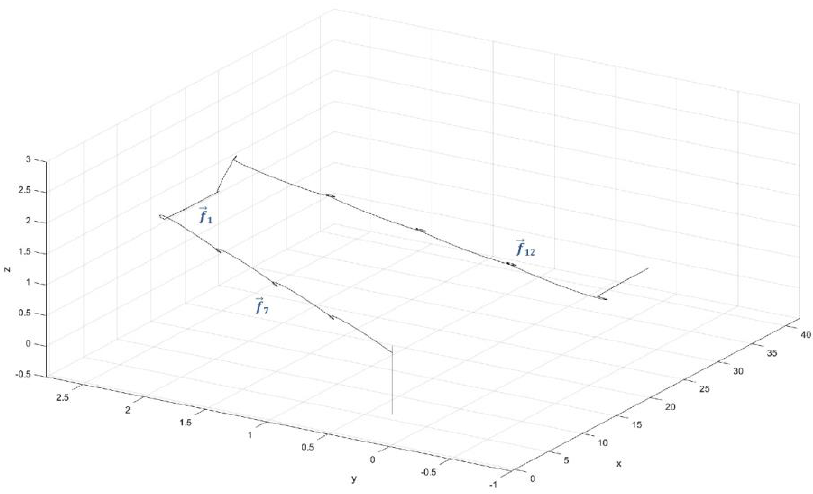
Figure 12. Trajectory generated by TGBOA algorithm results of three experiments and their use in the PI − like controller.